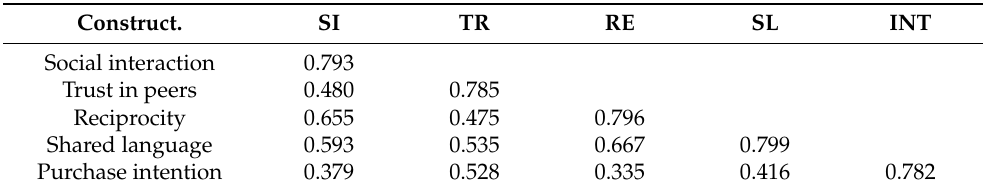
Table 2. Correlations and square root of AVE values.